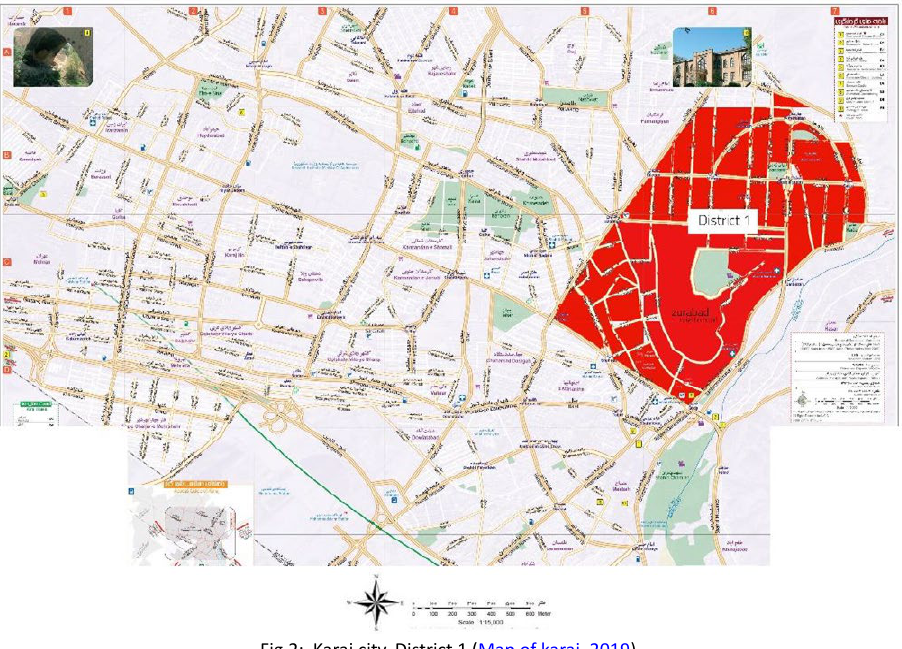
Fig.2: Karaj city, District 1 (Map of karaj, 2019 )